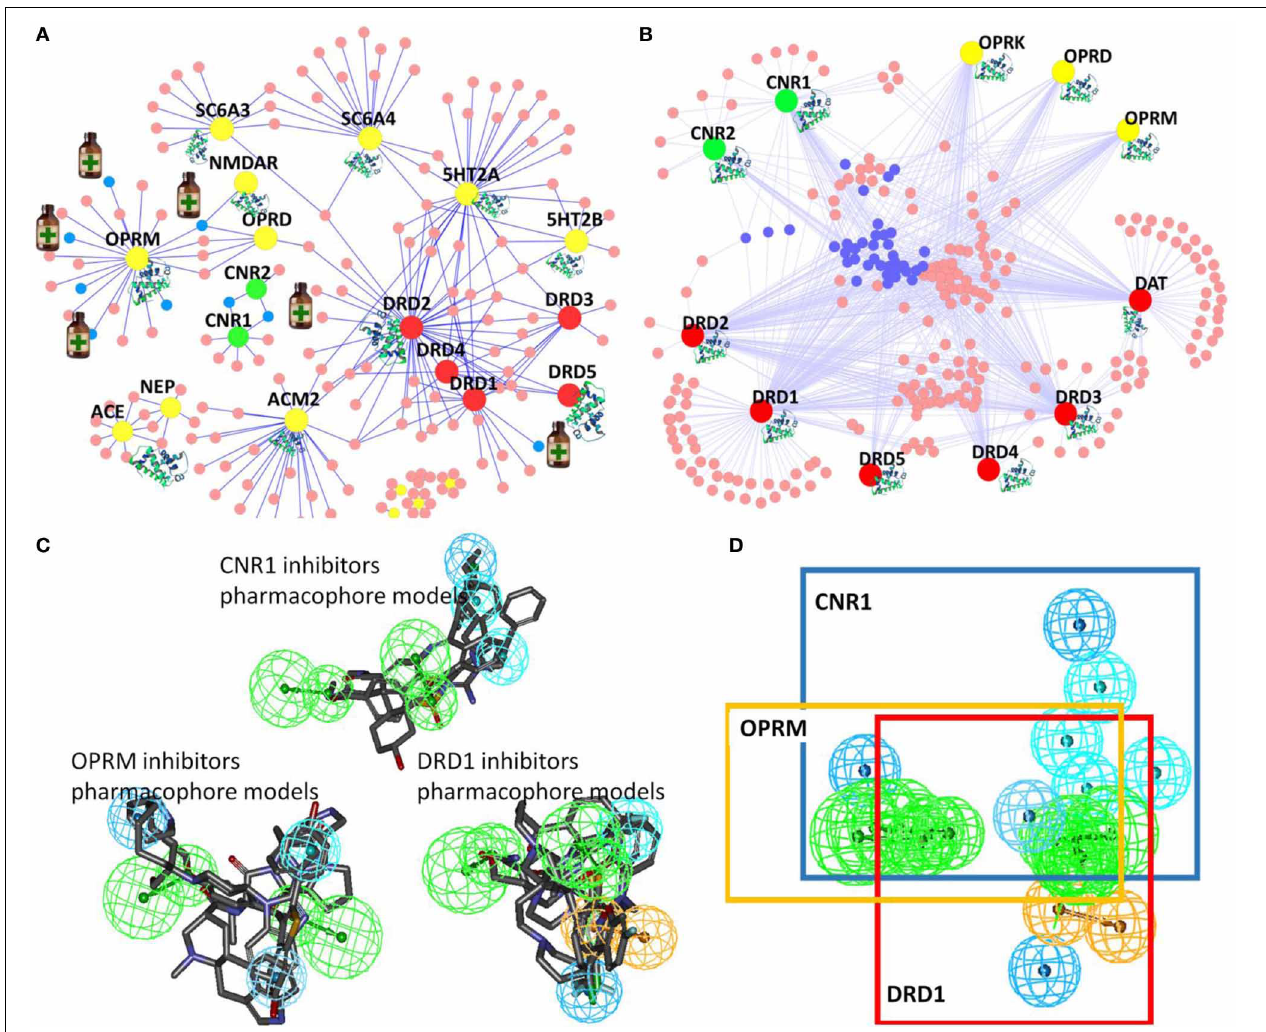
FIGURE 4 | Illustration of TargetHunter webserver ( www . cbligand . org/ TargetHunter ) for polypharmacology DA research. (A) TargetHunter mapping literature reported (abused) drugs-targets interactions. The large (yellow, green, and red) nodes represent targets. The small nodes (pink and blue) represent drugs, among which, seven, designated by medicine bottles (blue nodes), are approved/clinical trial medicine for DA treatments: (i) methadone, naltrexone, oxycodone, and buprenorphine targeting mu-opiate receptor (OPRM, large yellow nodes); (ii) Nabilone and Cannabidiol targeting cannabinoid receptor 1(CNR1 or CB1, large